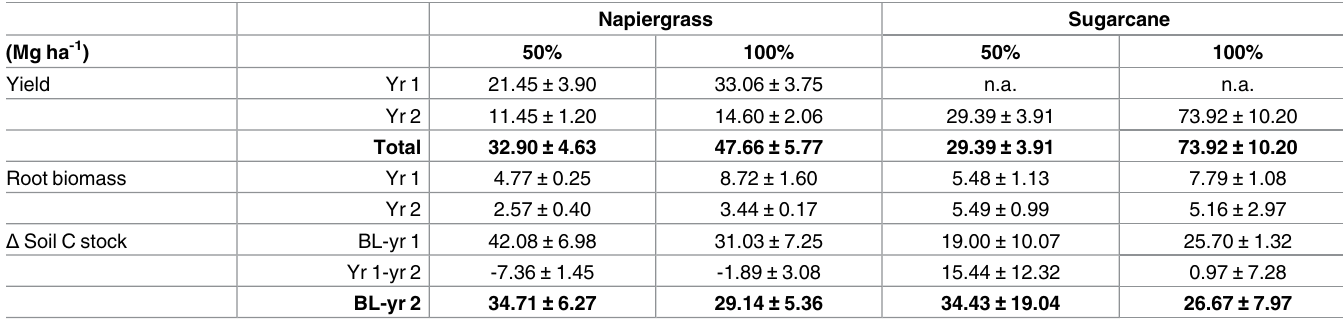
Table 1. Total stocks in above and belowground pools.